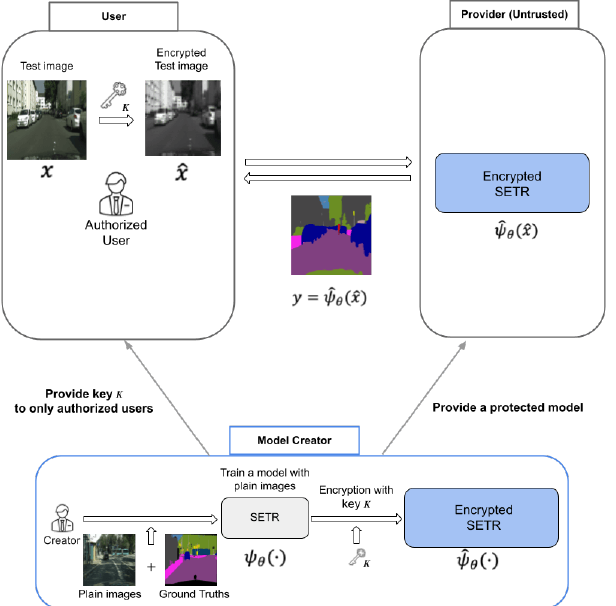
Figure 3. Overview of privacy-preserving semantic segmentation. (SETR: segmentation